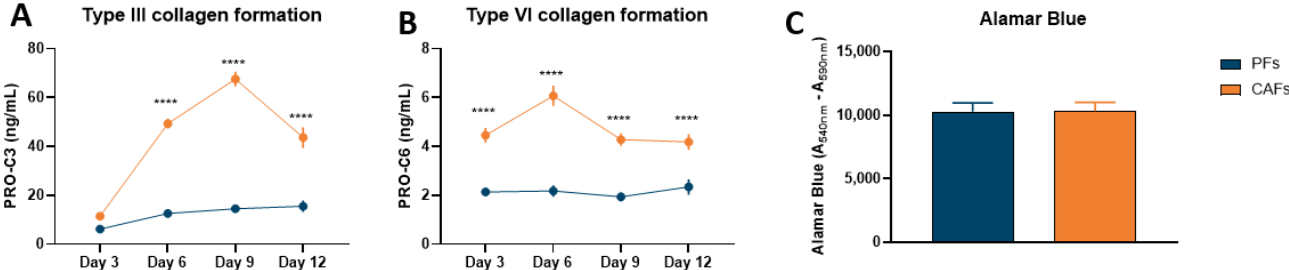
Figure 1. Fibrotic potential and metabolic activity in quiescent pancreatic fibroblasts (PFs) and pancreatic cancer-associated fibroblasts (CAFs). PRO-C3 ( A ) and PRO-C6 ( B ) were measured in supernatant from PFs and CAFs on day 3, 6, 9, and 12 after initiation of experiment. ( C ) On day 12 metabolic activity was assessed using Alamar Blue. n = 2–6 technical replicates and 3–5 biological replicates.. **** p < 0.0001. A p < 0.05 was considered significant.